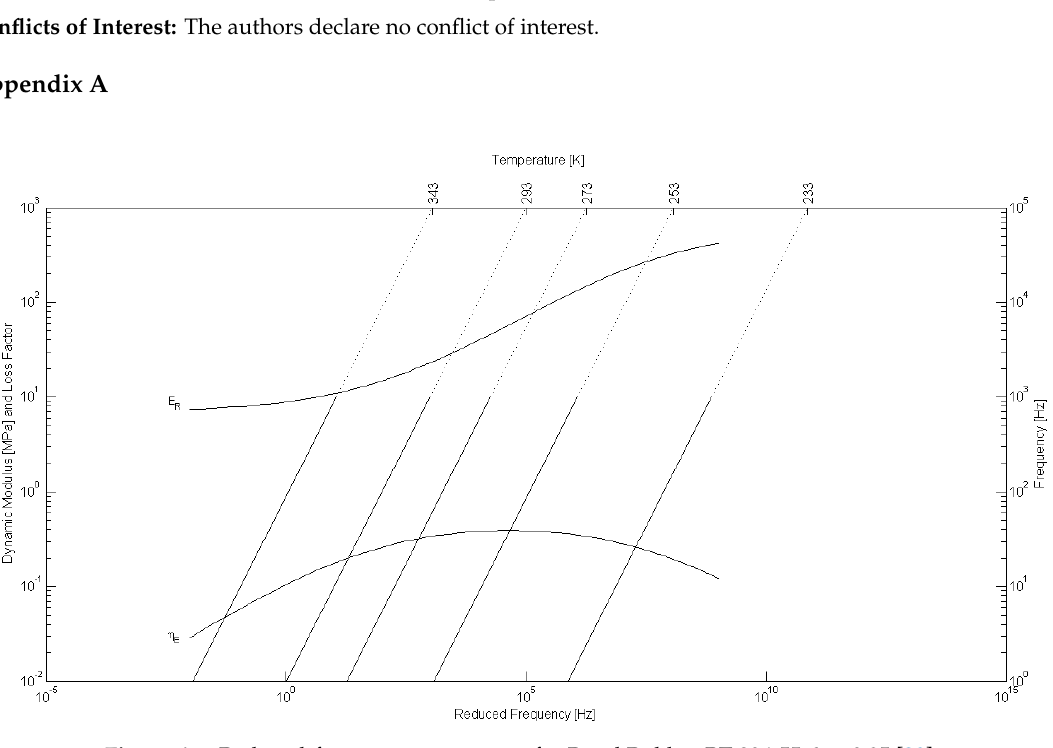
Figure A1. Reduced-frequency nomogram for Butyl Rubber BT 806-55; λ = 0.95 [29].